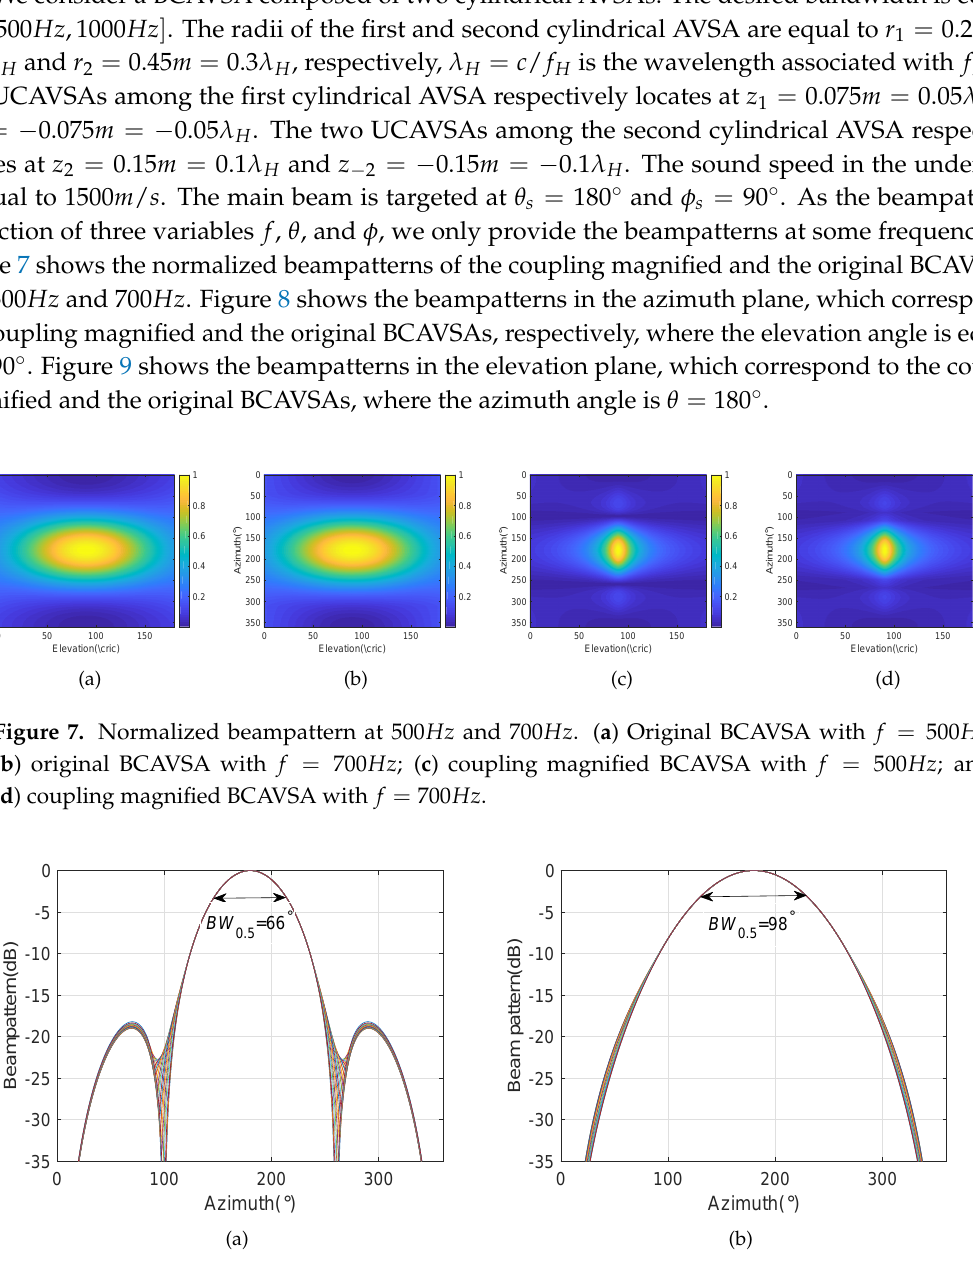
Figure 8. Beampattern in the azimuth plane with the elevation angle φ = 90 ◦ , where the beampattern is steered at θ s = 180 ◦ . ( a ) Coupling magnified BCAVSA; ( b ) original